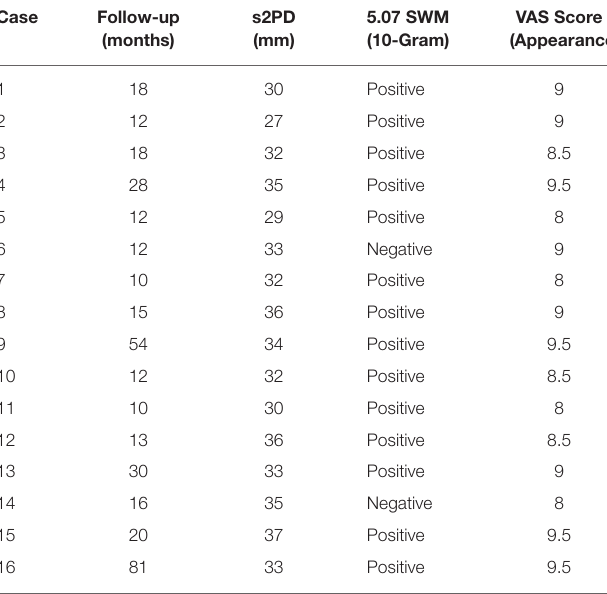
TABLE 2 | Follow-up aesthetic and sensory outcome evaluation.